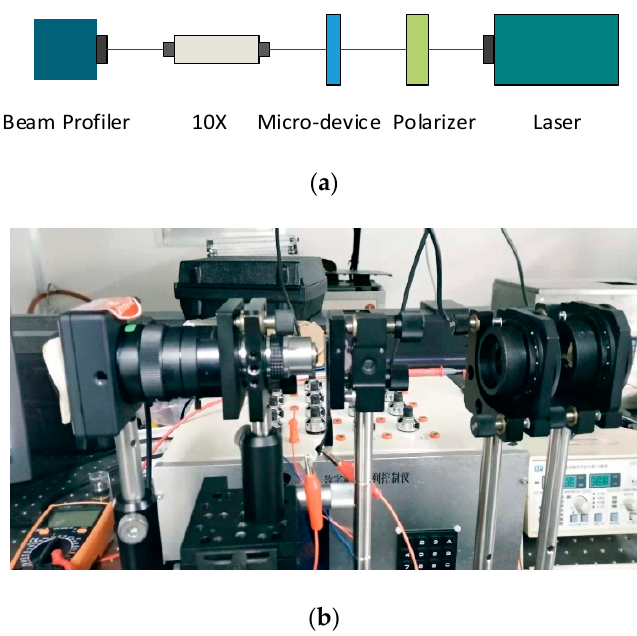
Figure 3. Optical measurement platform for zooming performance—( a ) schematic diagram and ( b ) actual testing platform.